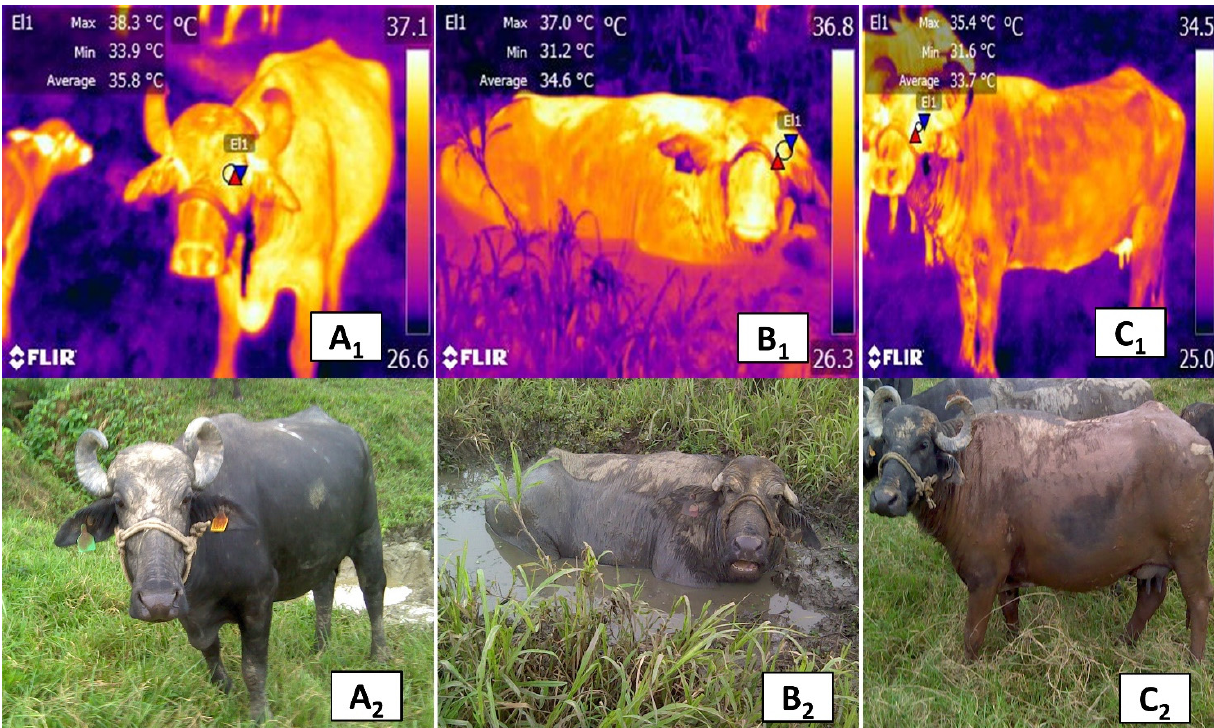
Figure 10. Thermal response of the orbital region of river buffaloes ( Bubalus bubalis ) under direct solar radiation, then during and after wallowing. ( A 1 , A 2 ) Effect of direct radiation. The temperature of the orbital region (El1) shows a maximum temperature of 38.3 °C (red triangle) and a minimum of 33.9 °C (blue triangle). These temperatures are due to the effect of heat dissipation through vasodilation of skin blood vessels. ( B 1 , B 2 ) Wallowing and its effect on orbital temperature. Decreases in the maximum and minimum ocular temperatures of 1.3 °C (red triangle) and 2.7 °C (blue triangle), are observed when the animals submerge in muddy waters to thermoregulate. ( C 1 , C 2 ) Effect of wind on orbital temperature after muddying. The maximum and minimum orbital temperatures decreased by 2.9 °C (red triangle) and 2.3 °C (blue triangle), compared to baseline values. This effect was caused by mud in the dorsal region and the combined cooling effect of convection of the wind and evaporation of water in mud on this zone; a strategy river buffaloes use to reach thermal comfort.